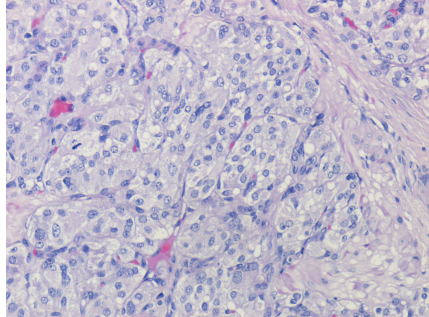
Figure 1: Axial CT scan of the pelvis after IV contrast: oval shape well-defined homogenous small mass at the bladder neck which shows intense enhancement after contrast.